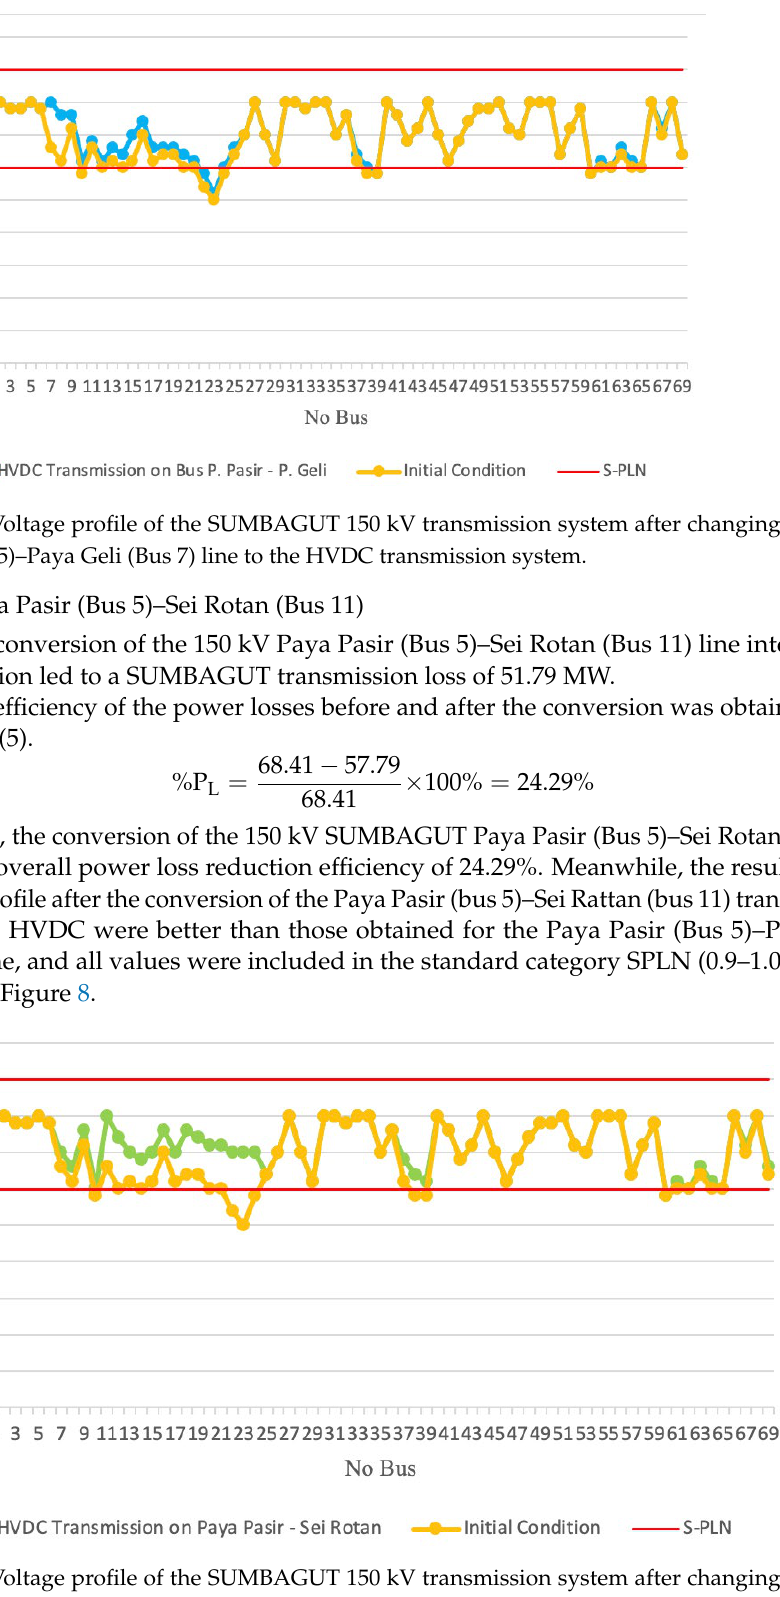
Figure 8. Voltage profile of the SUMBAGUT 150 kV transmission system after changing the Paya Pasir (Bus 5)–Sei Rotan (Bus 11) line to the HVDC transmission Pasir (Bus 5)–Sei Rotan (Bus 11) line to the HVDC transmission system. 3.3.3. Renun (Bus 66)–Sidikalang (Bus 63)